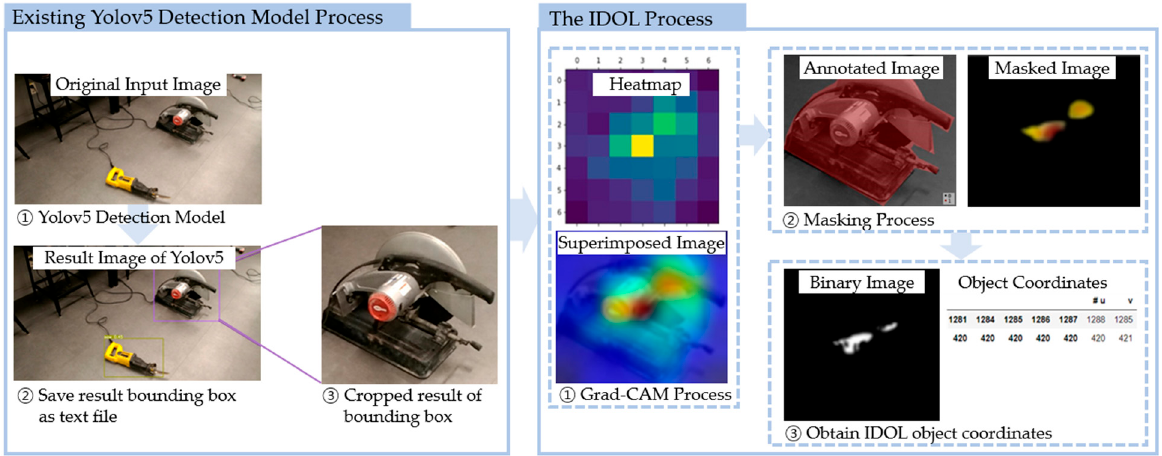
Figure 1. Process of the IDOL algorithm.